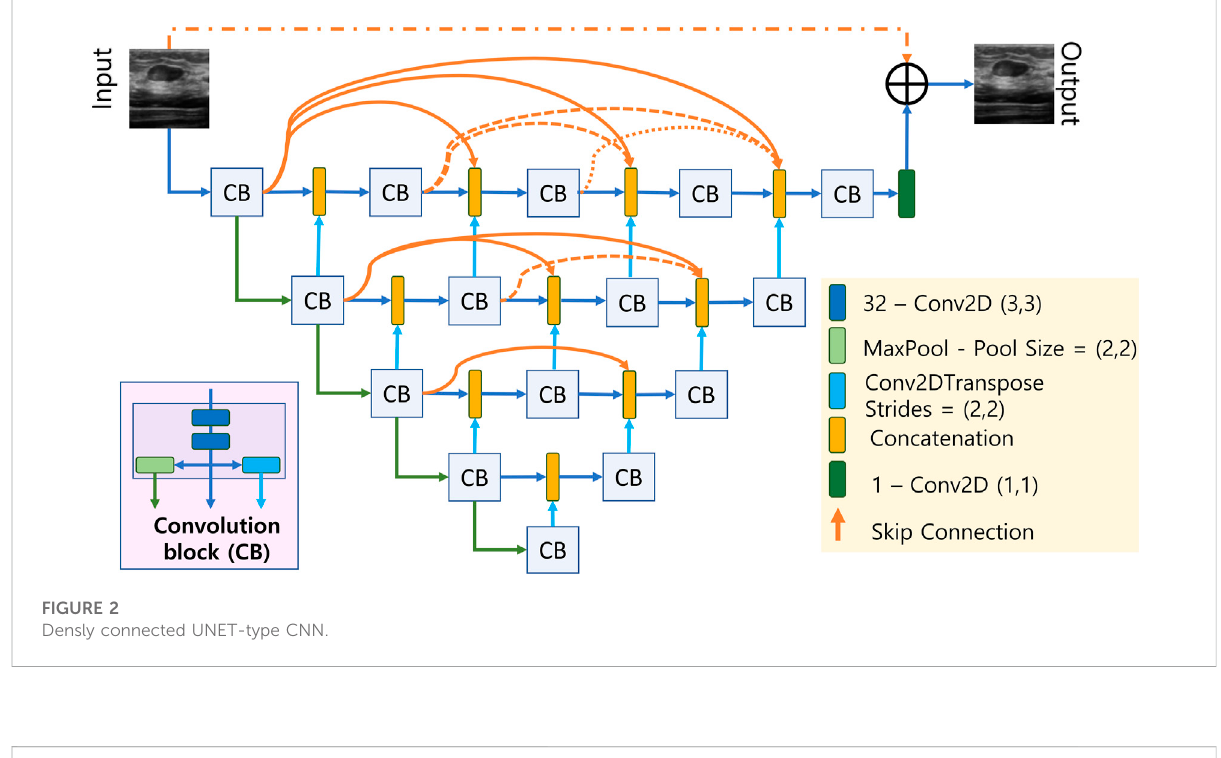
FIGURE 2 Densly connected UNET-type CNN.